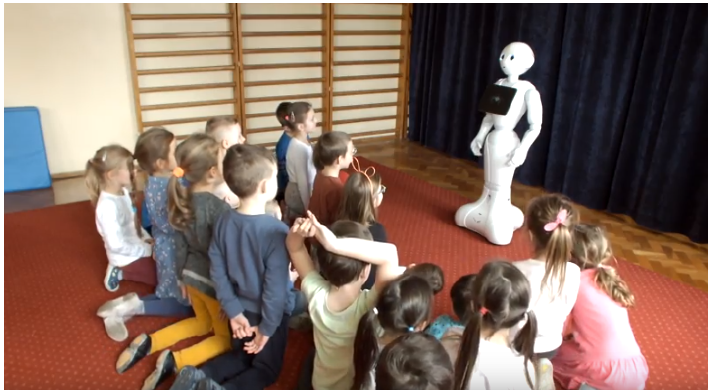
Figure 6. Polish children raising their hands to ask a